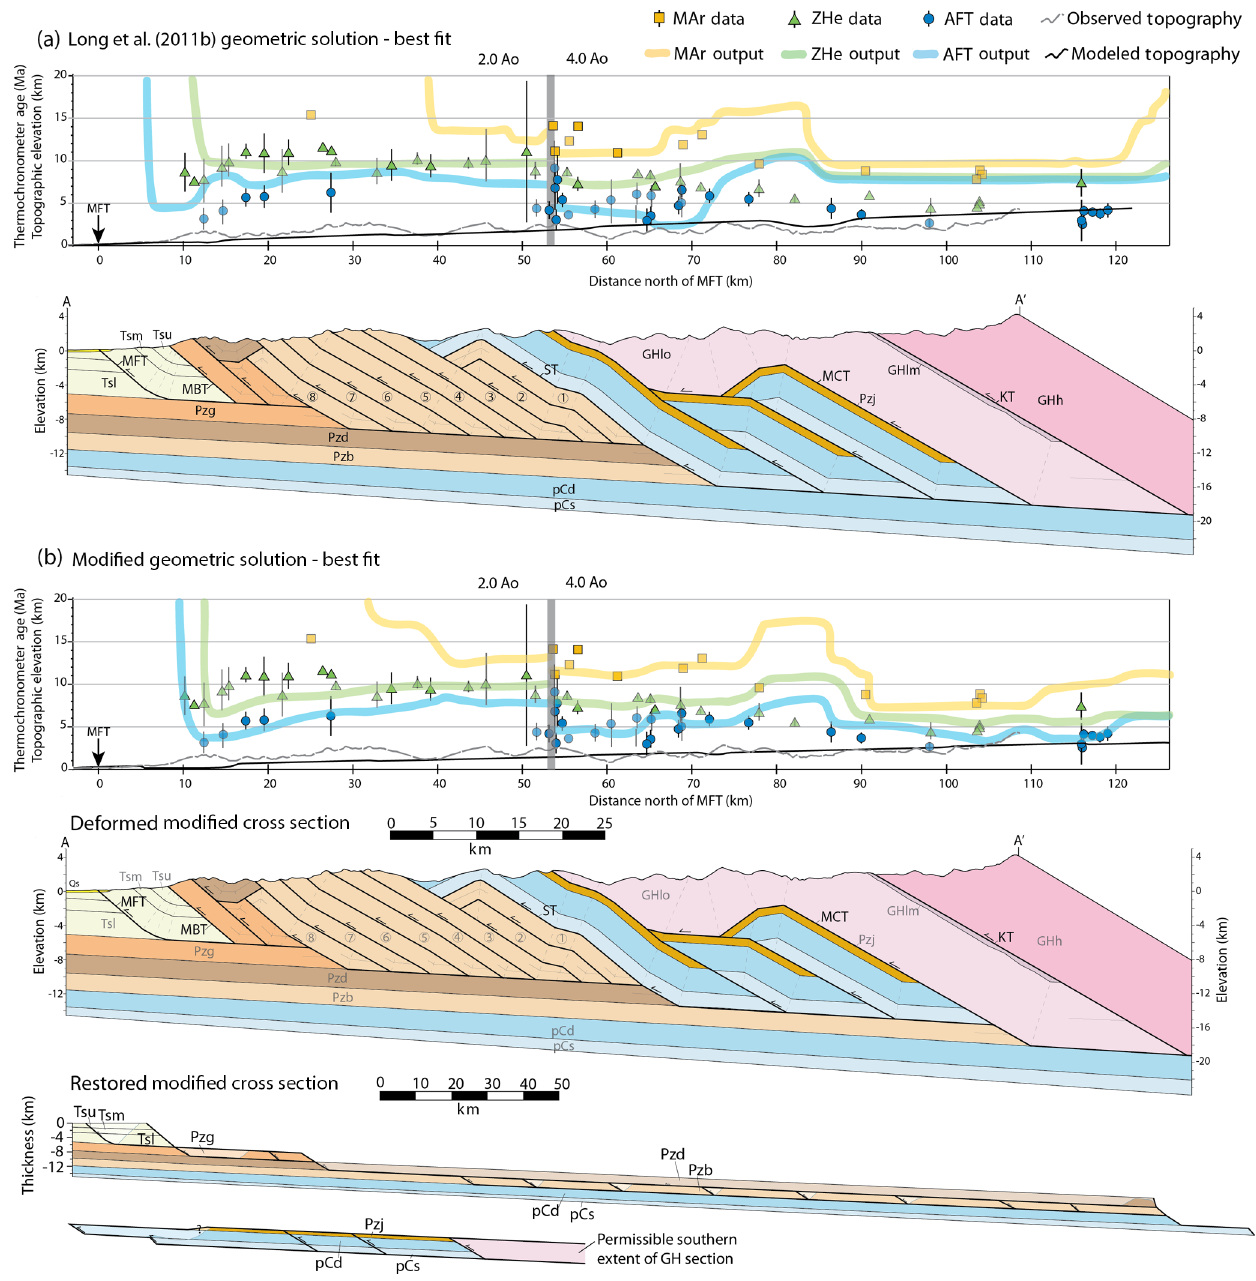
Figure 9. Predicted MAr (yellow), ZHe (green), and AFT (blue) cooling ages using flexural–kinematic models of (a) the original geometric solution by Long et al. (2011b) with responsive topography and velocity B and (b) a modified geometric solution with responsive topography and preferred velocity. The décollement ramp through the upper LH Baxa and Diuri units has been split and the Baxa footwall ramp moved 35km north. Published data include additional ages from the Kuru Chu line of section 30km west of the Trashigang section (Long et al., 2012) and are indicated by transparent thermochronometer symbols. The grey vertical lines aligned with the location of the MCT show the division between outputs from separate thermal models merged using 2.0 and 4.0µWm − 3 to the south and north of the MCT, respectively. Other model variables are set as Split KT and velocity